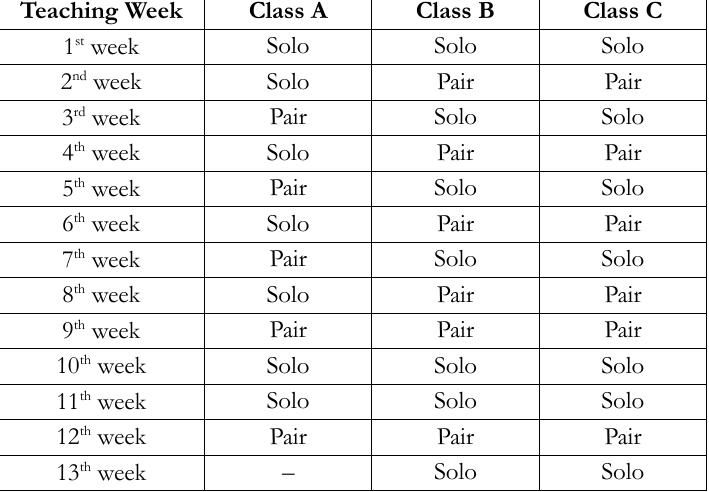
Table 1. Pair and Solo Programming Session Distribution